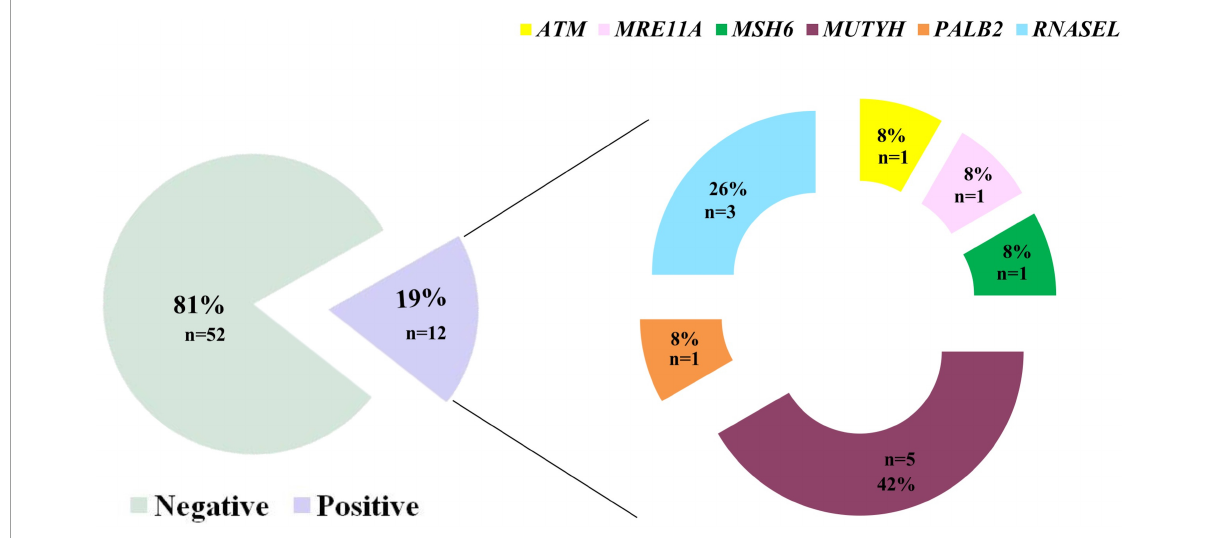
FIGURE2 Results of the multi-gene panel testing based on NGS-approach in this study group ( N = 63 totally analyzed patients). Eighty-three% of patients were found not to be carriers of pathogenic variants, while 17% was positive for the presence of a clinically interesting mutation. Interestingly, we highlight that MUTYH carried most of the variants identified herein (46%) followed by the RNASEL gene